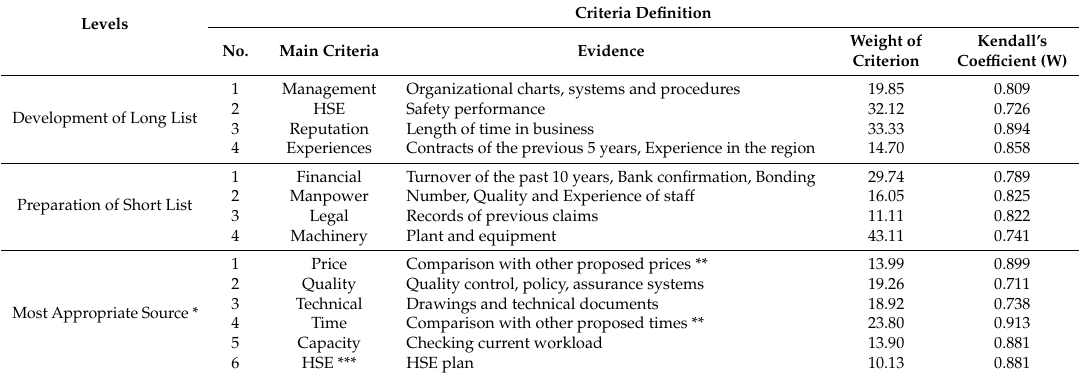
Table 6. Criteria development of Construction General Contractor and their weights.